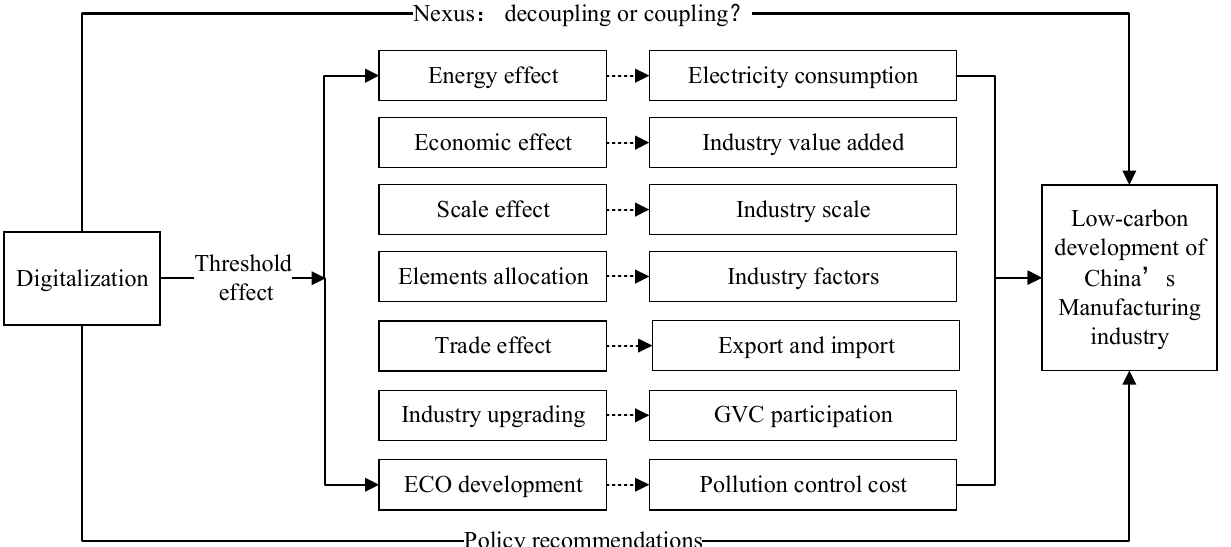
Figure 4. Research framework and theoretical